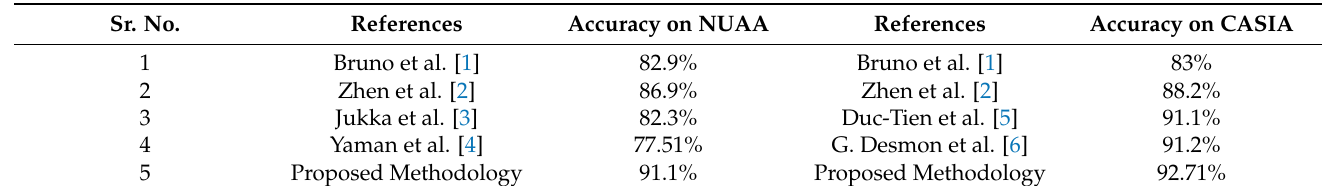
Table 5. Accuracy Comparison for Face Spoofing on NUAA and CASIA. Sr. No.